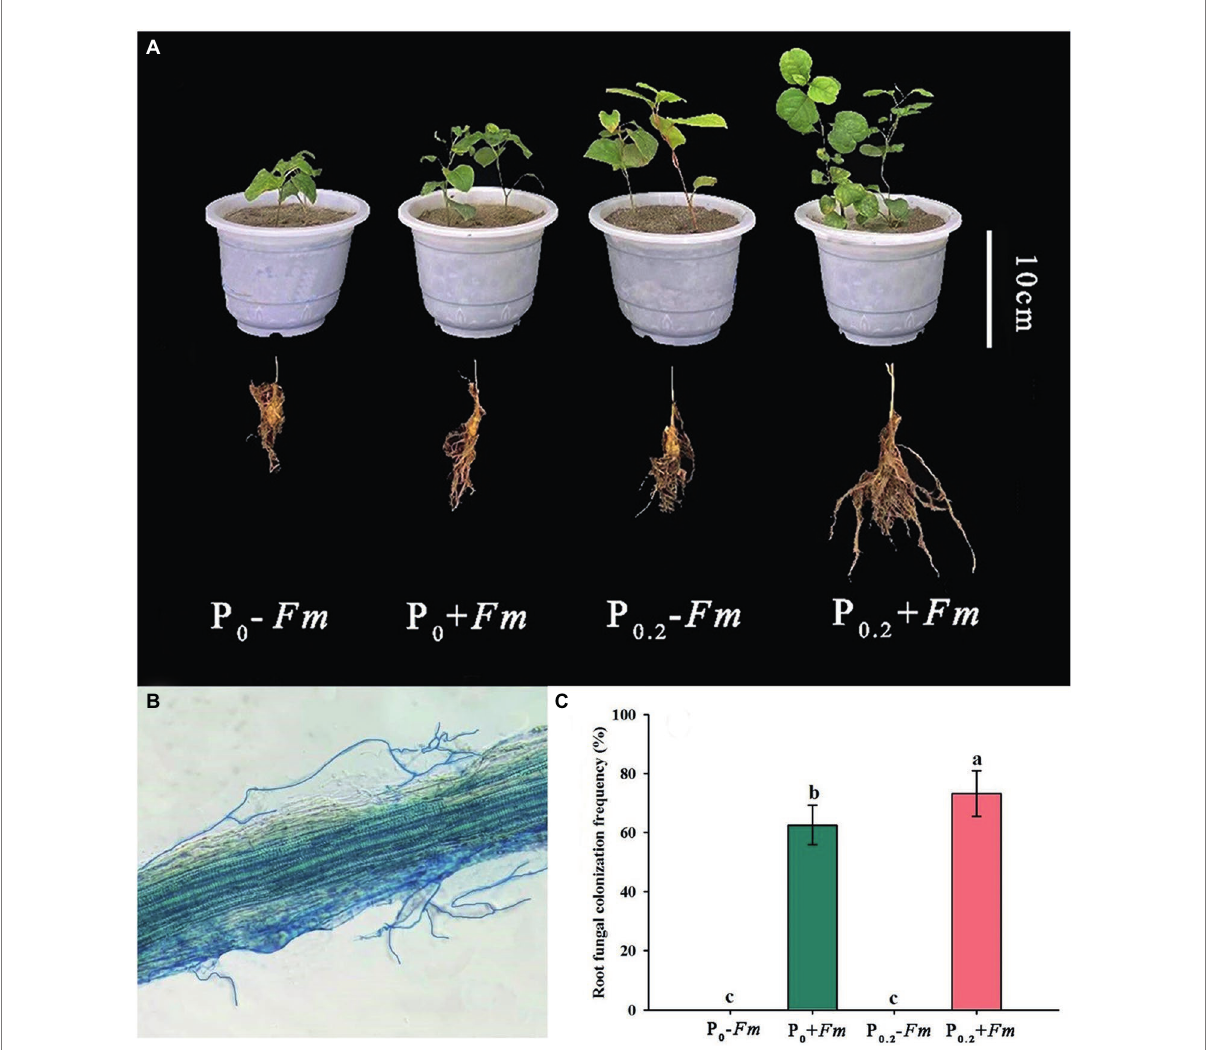
FIGURE 1 Plant growth responses (A) , root fungal colonization (B), and changes in root fungal colonization rate (C) of Polygonum cuspidatum to Funneliformis mosseae and P supply. Data (means ± SD, n = 4)followed by different letters above the bars indicate significant ( p < 0.05) differences among treatments. + Fm , inoculation with F. mosseae ; − Fm , inoculation without F . mosseae ; P 0 , 0 M P; P 0.2 , 0.2 M P; P,